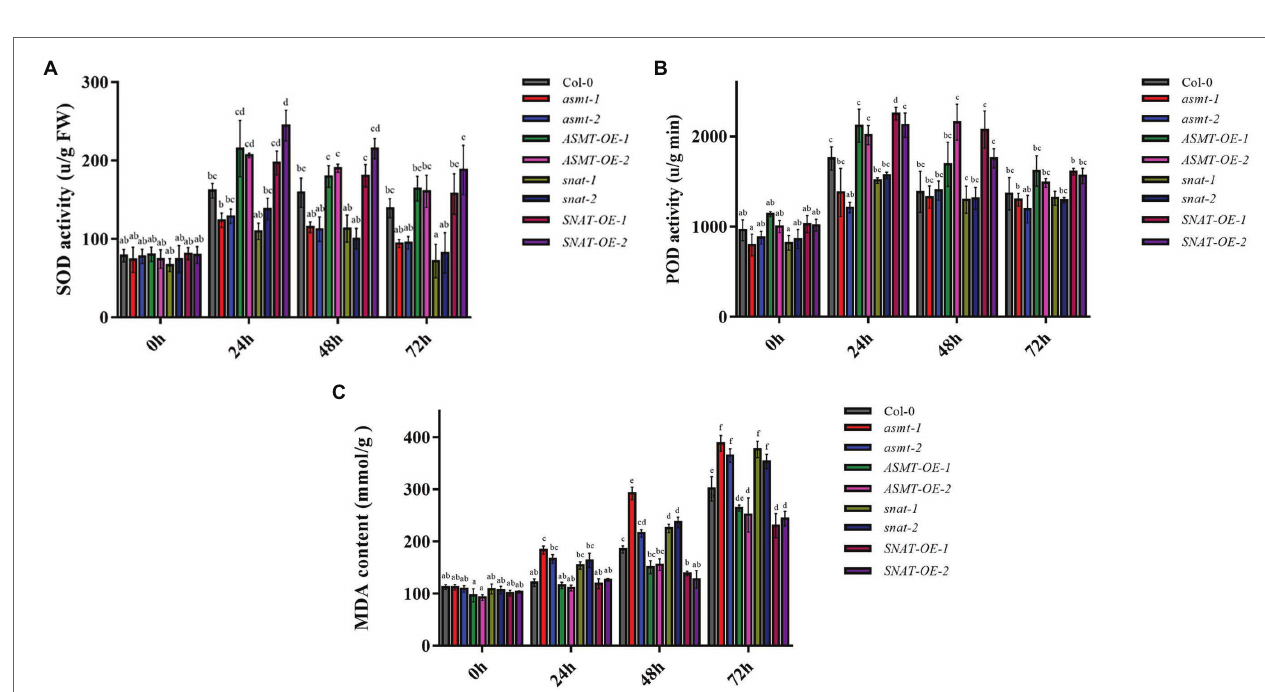
FIGURE 3 | The activities of antioxidant enzymes (A) superoxide dismutase (SOD) activity and (B) peroxidase (POD) activity and (C) the content of malondialdehyde (MDA) following B. cinerea treatment. Significant differences among 4-week old wild-type (Col-0), ASMT -overexpressed ( ASMT-OE-1 , ASMT-OE-2 ) plants, SNAT -overexpressed ( SNAT-OE-1 , SNAT-OE-2 ) plants, snat silencing lines ( snat-1 , snat-2 ), and asmt silencing lines ( asmt-1 , asmt-2 ) at different time points (0, 24, 48, and 72 h) after the B. cinerea infection. The data (mean ± SD) were calculated using three replicate assays, with the SEs indicated by the vertical bars. Different lowercase letters indicate statistically significant differences ( p < 0.05). FW, fresh